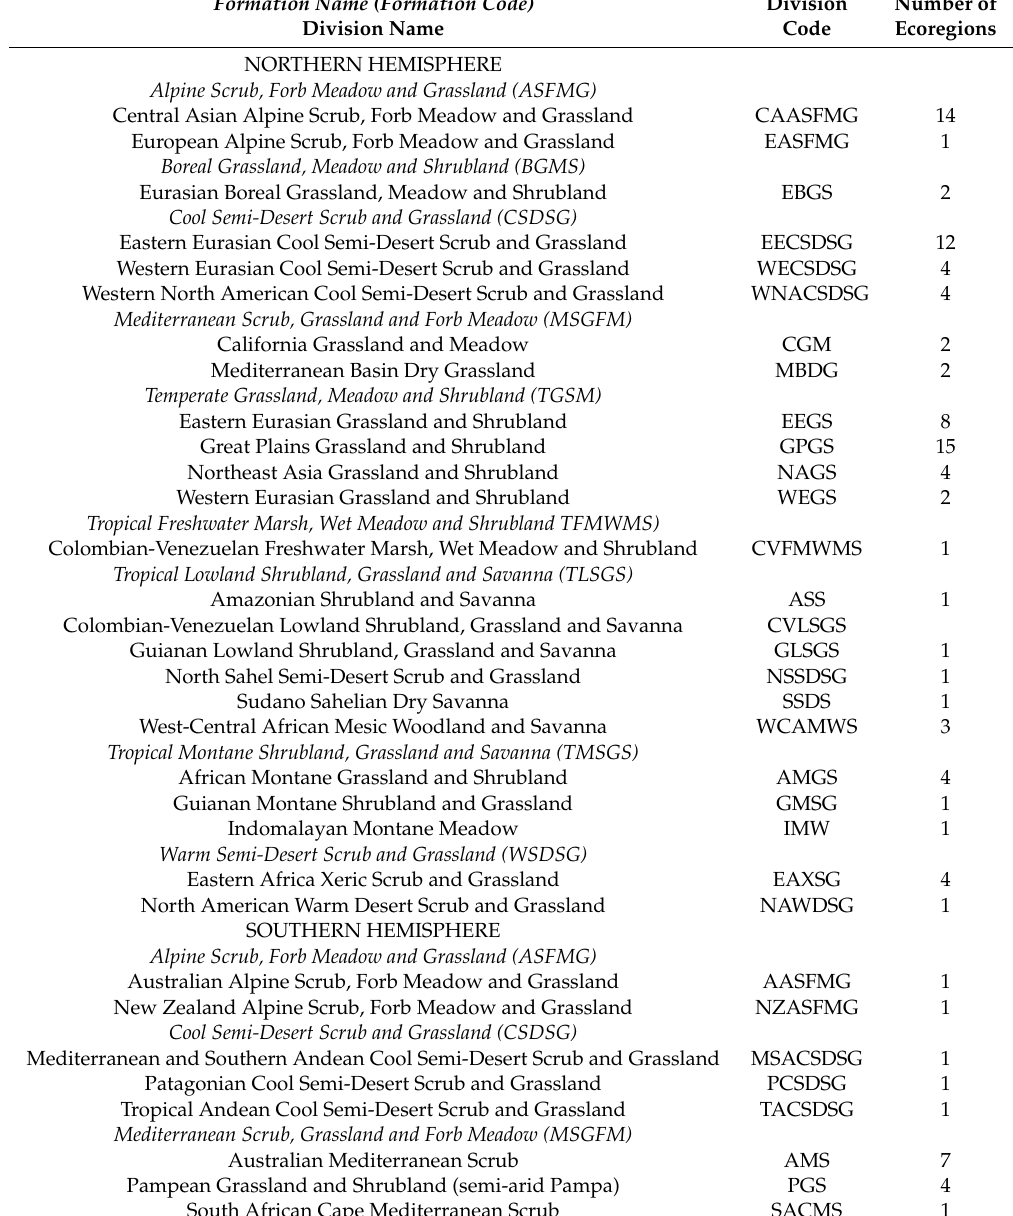
Table A2. World Grassland Type Formations and Divisions (Dixon et al.,